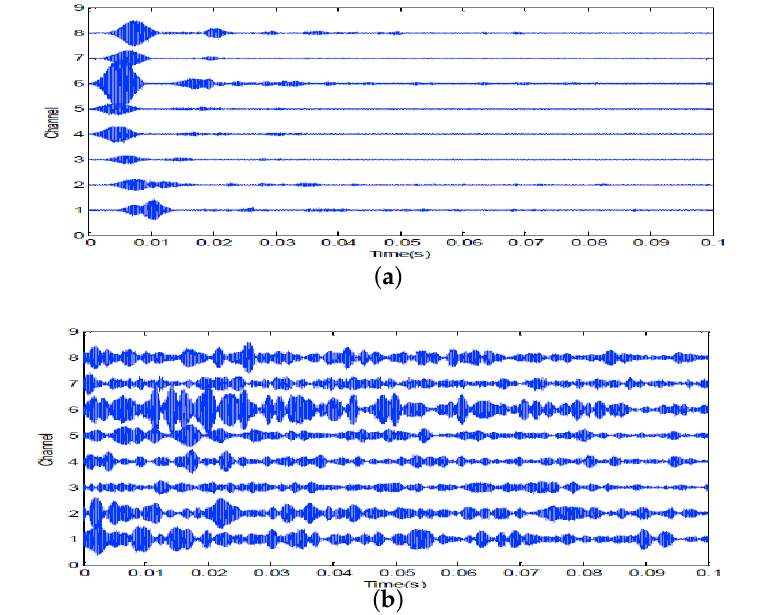
Figure 17. LFM signal at 6–7.5 kHz: ( a ) echoes received by SRA1 after transmitting a probing signal; ( b ) the time-reversed signal for the second transmission.